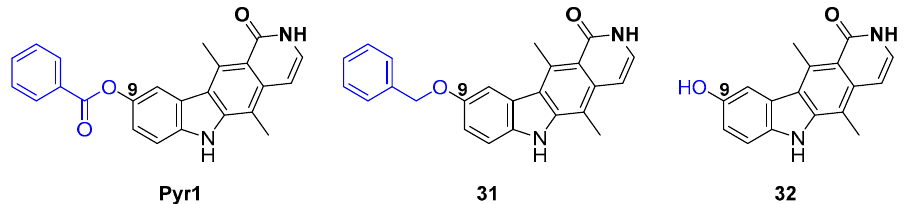
Figure 9. Pyr 1, O -benzyl derivative ( 31 ), and 9-OH metabolite ( 32 ).